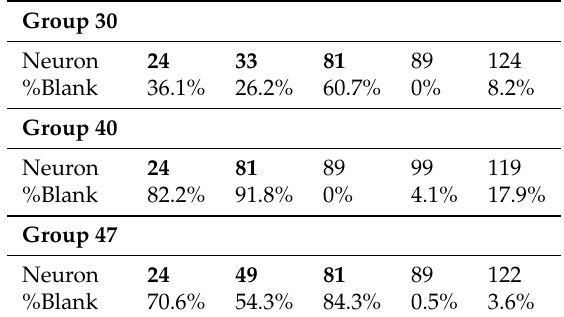
Table 4. The percentage of blank saliency maps for each of the five neurons with the highest absolute KS-values (compared to group 50) in the Dense-128 layer. The percentages only include saliency maps from the images classified as members of the respective failure mode group. Blank saliency maps do not contribute to the subsequent layers in the network because the activation is zero. The neuron numbers with bold font are the neurons qualitatively identified as encoding digit five. We observe that the neurons encoding digit five have predominantly larger percentages of blank saliency maps. This means that digit five receives lower probability for the number of images equating to the percentage of blank saliency